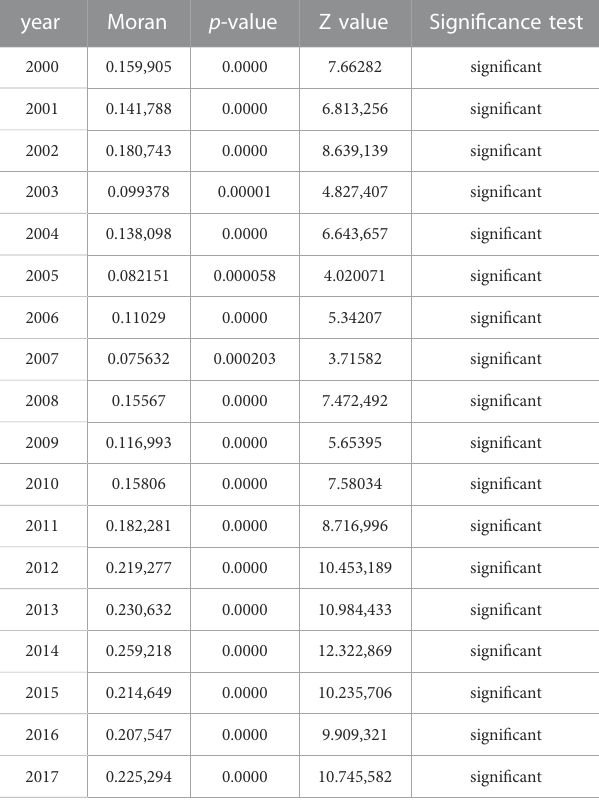
TABLE 1 China ’ s urban global moran index 2000 –